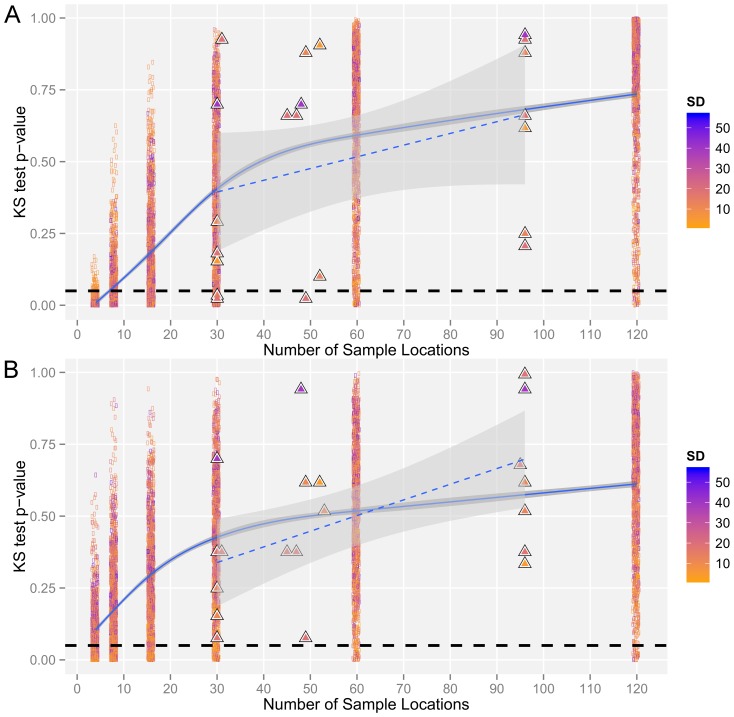
Comparison of sample representation across 25 km2 of Amazonian forest.The sample representativeness of altitude values was determined in two sets of 5×5 km sample areas [1286 randomly selected (rectangles) and seven active research areas (triangles)] across the Brazilian Amazon. Within each area, the representativeness of (a) samples and (b) their corresponding IDW interpolations were evaluated. The distribution of values was compared with that of the area altitude (SRTM DEM) values using the Kolmogorov-Smirnov (KS) test. Increasing p-values denote more similar distributions (i.e. samples/interpolations are more representative). The blue lines (solid  =  randomly selected and dashed  =  active research areas) and shaded areas are the mean value and 95% confidence intervals from a GAM model illustrating the trend in representativeness with increasing sample size. The filled colors show the standard deviation (SD) of altitude values within each of the different sample areas. The black dashed horizontal line shows a p-value of 0.05.